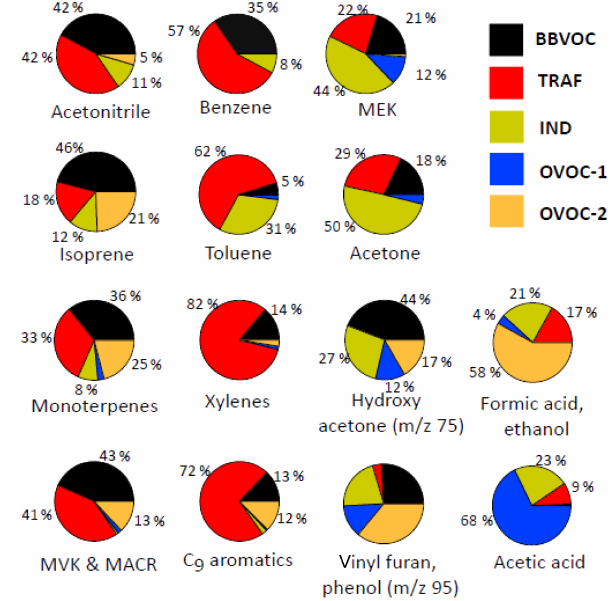
Figure 11. Species percentage (%) attributed to the PMF factors for the Athens winter campaign for the five-factor